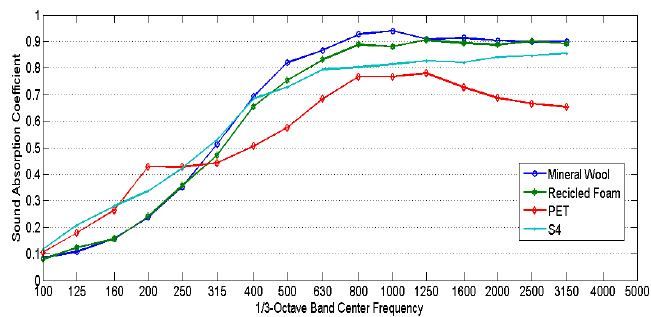
Figure 7. Comparison between the diffuse field sound absorption coefficients of sheep wool sample S4, mineral wool, recycled poliurethane foam and polyester fibers (PET).